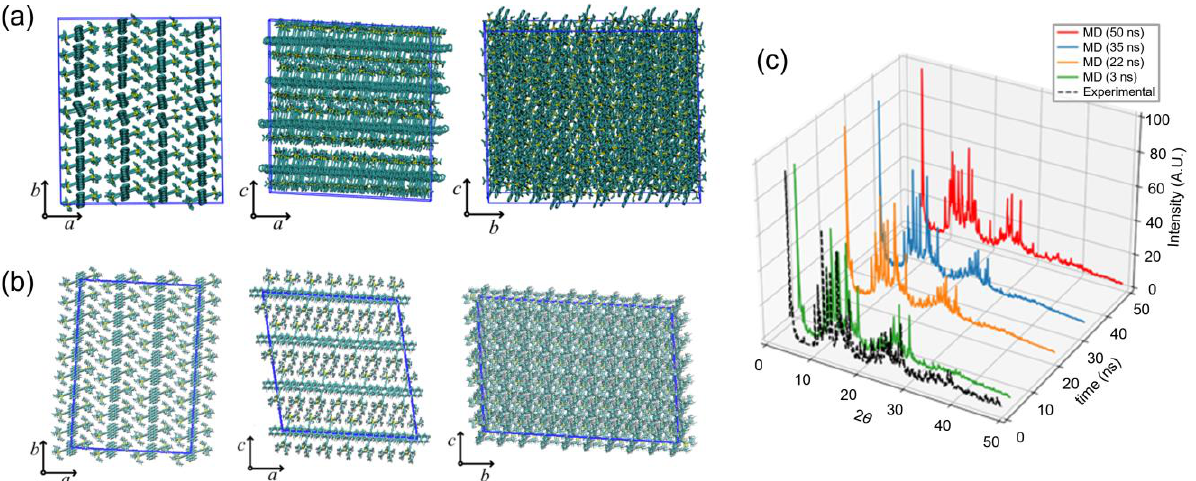
Figure 3. ( a ) The different views of a representative equilibrium configuration of TIPS-P crystalline structure obtained via MD simulation. ( b ) The different views of the TIPS-P crystalline structure obtained via experiment [36]. ( c ) Comparison between simulated and experimental [36] powder X-ray diffraction patterns of the TIPS-P